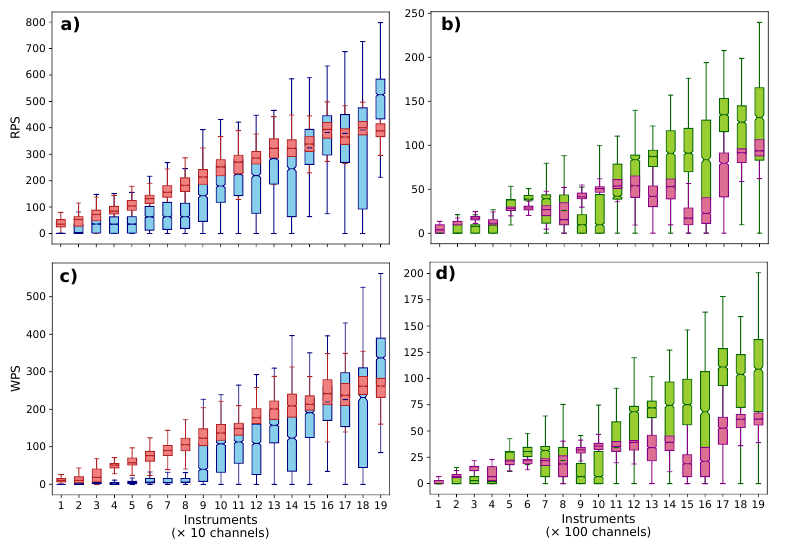
Figure 3. Disk usage versus number of monitored instruments in a single DAQBroker server on a LP machine ( a) and c) and a HP machine ( b) and d) . The top plots ( a) and b) show writes per second and the bottom plots show reads per second ( c) and d)